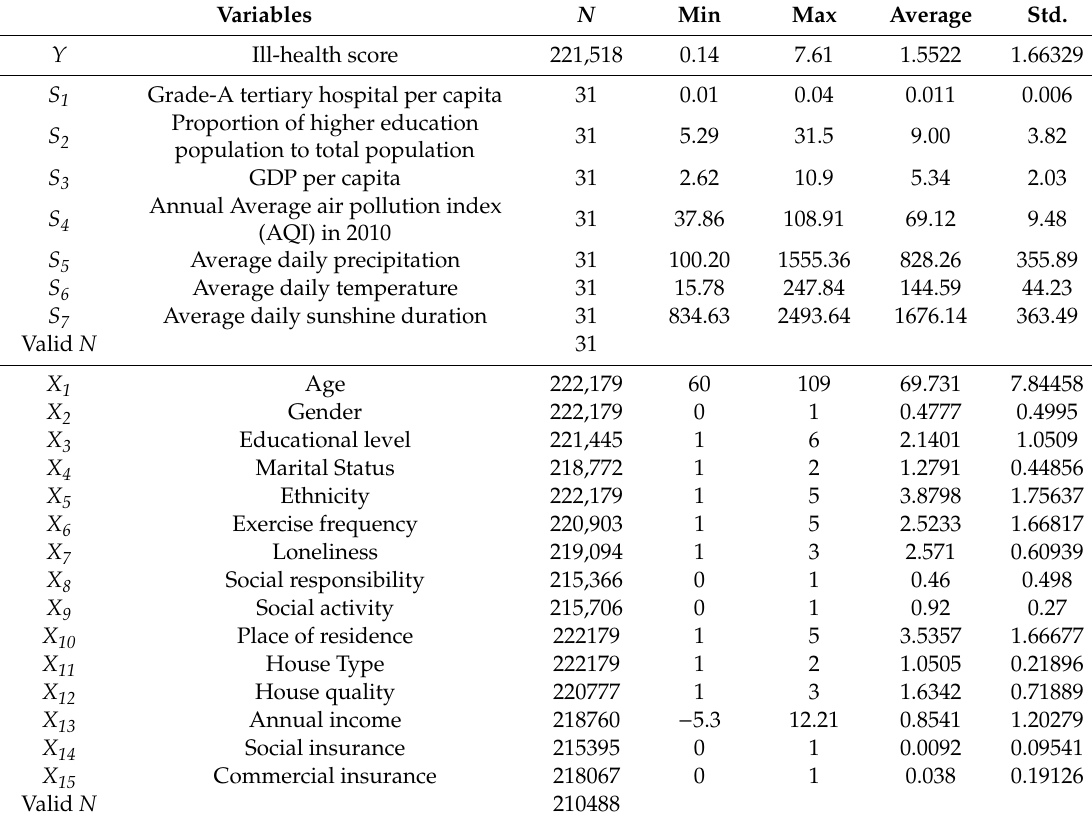
Figure 1. Inter-province differences for economic, medical resources, educational and environment in China. (a) Grade-A Tertiary Hospital Per capita; (b) proportion of higher education population to total population; (c) GDP per capita; (d) annual average air pollution index in 2010; (e) average daily precipitation; (f) average daily temperature; (g) average daily sunshine duration. Table 2. Descriptive statistics of provincial-level and individual-level variables.